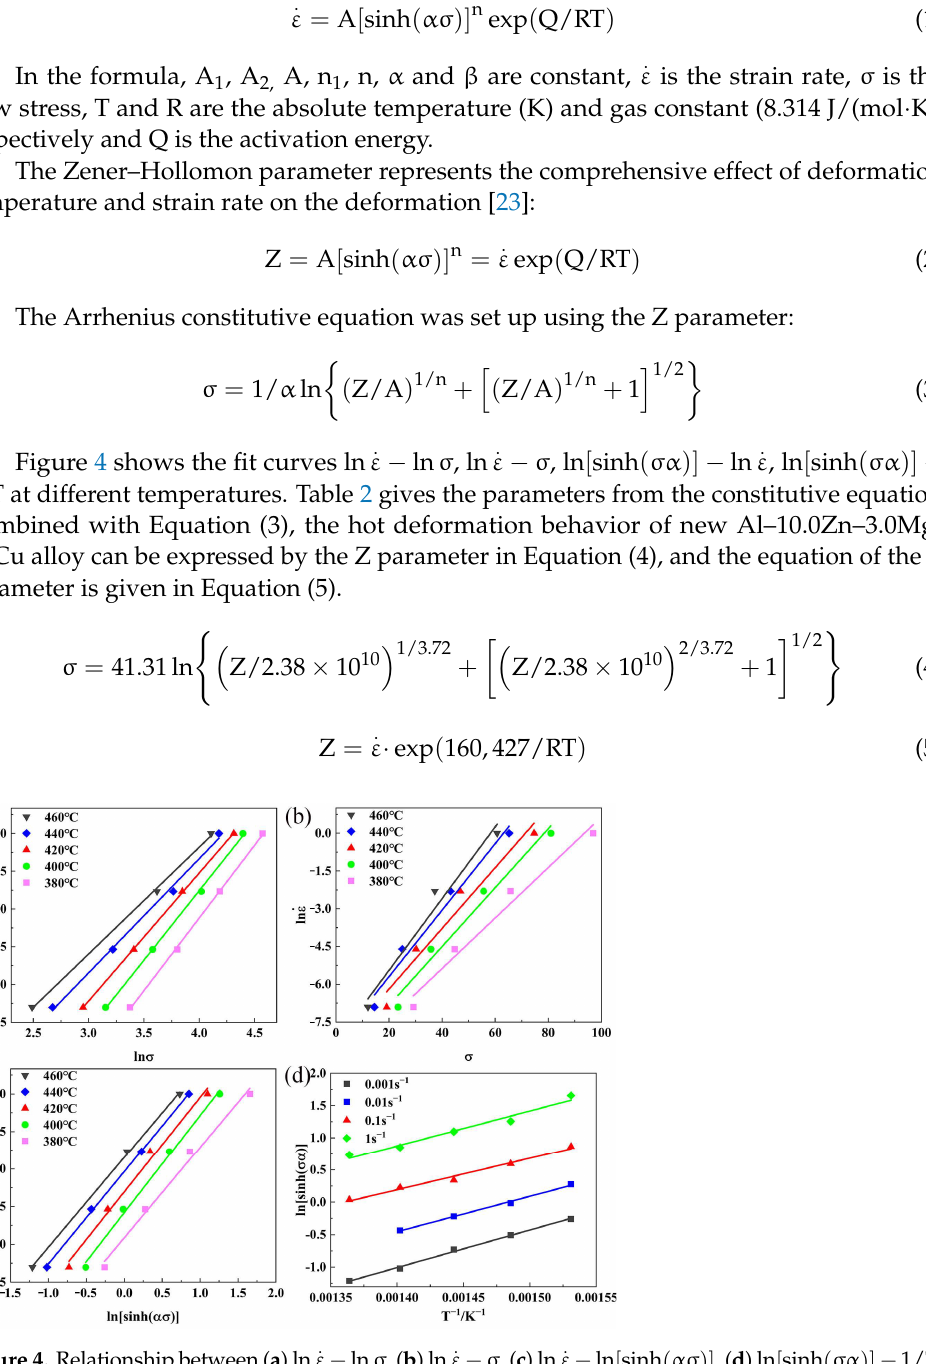
Figure 4. Relationship between ( a ) ln𝜀̇ − ln𝜎 , ( b ) ln𝜀̇ − 𝜎 , ( c ) ln𝜀̇ − ln [sinh (𝑎𝜎)] , ( d ) ln [sinh (𝜎𝑎)] − 1/T . Table 2. Parameters in constitutive